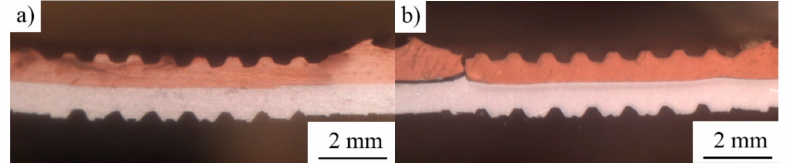
Figure 8. Profile of weld cross-section ( a ) RUSW at 0.2 s, and ( b ) HPUSW at 0.4